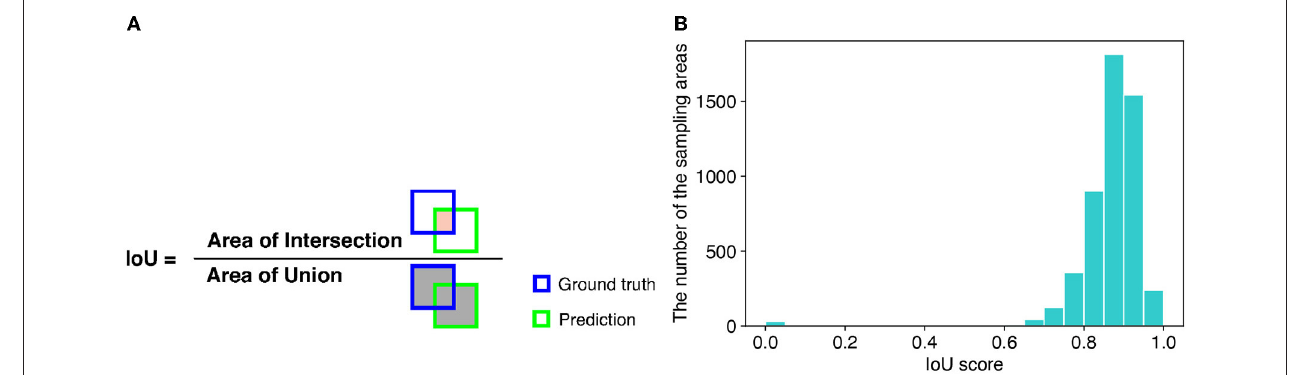
FIGURE 6 | (A) Definition of the IoU. The IoU is calculated as the ratio of the intersection between the ground truth and predicted area, denoted in orange, over their union, denoted in gray. (B) Distribution of IoU scores in intersection detection.